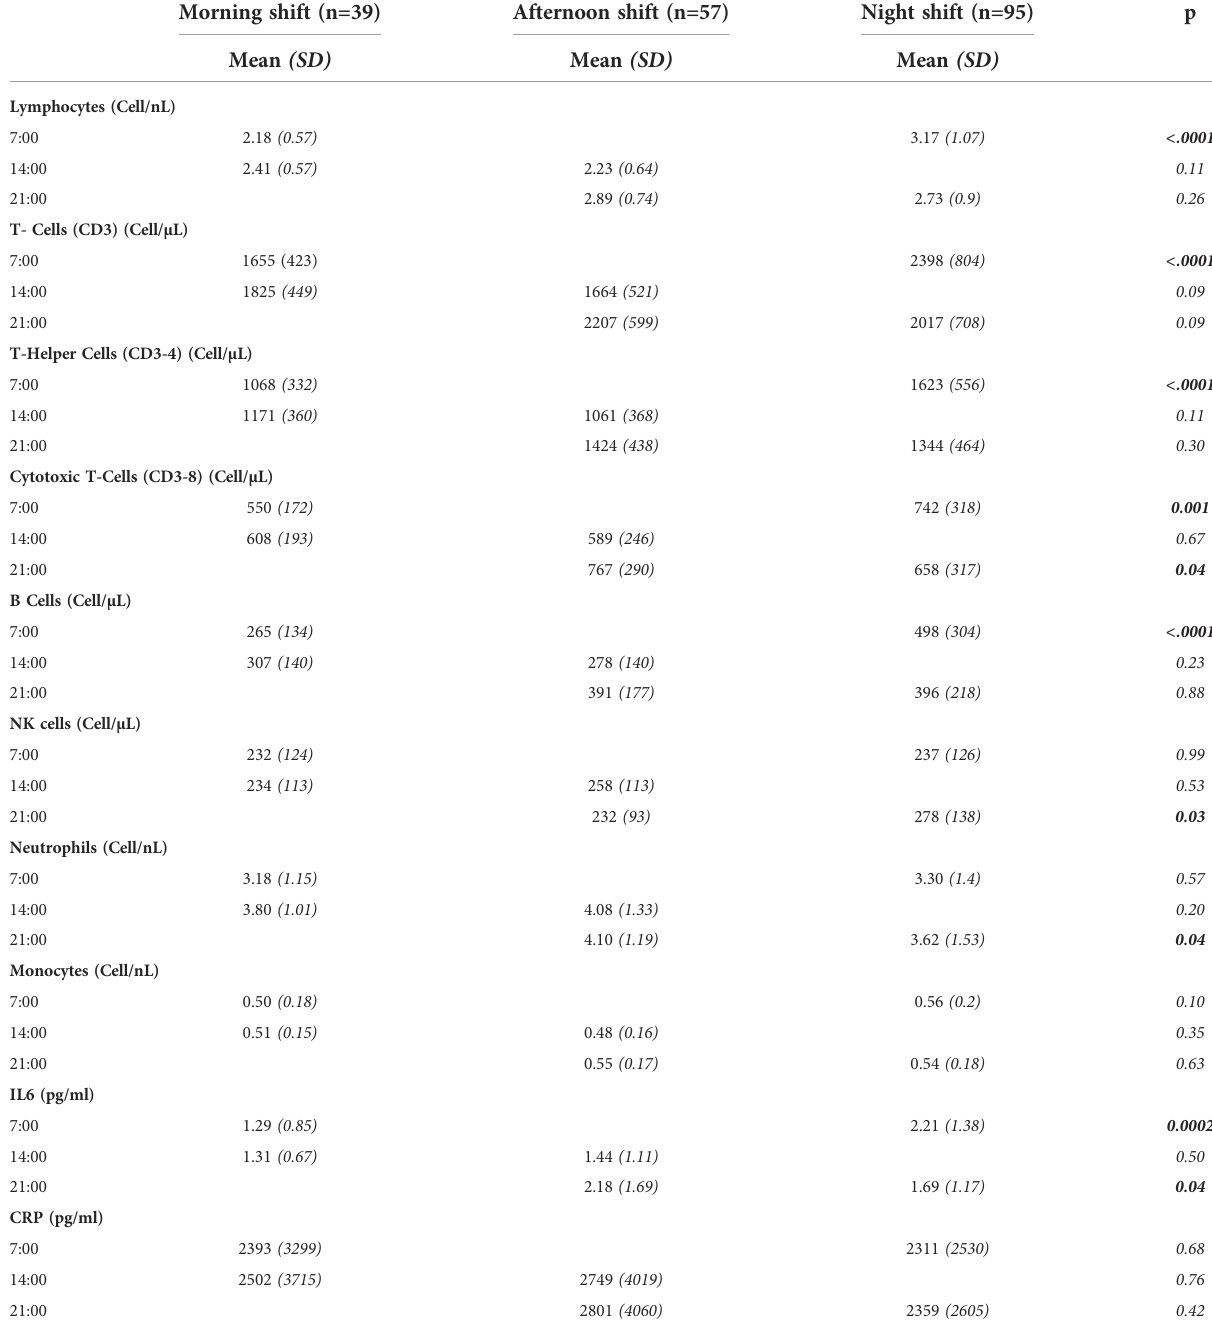
TABLE 3 Age-adjusted means and standard deviation (SD) of immune cells and in fl ammatory biomarkers before and after workshift in morning, afternoon, and night shifters. Morning shift (n=39) Afternoon shift